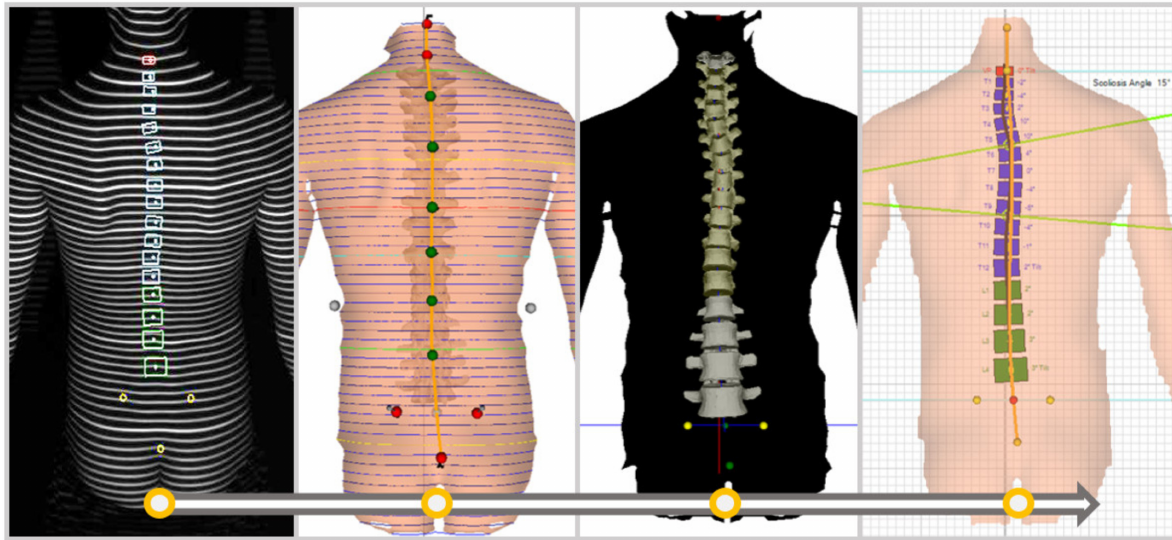
Figure 1. Spine structure analysis using video rasterstereography image of a patient’s back in the upright position.